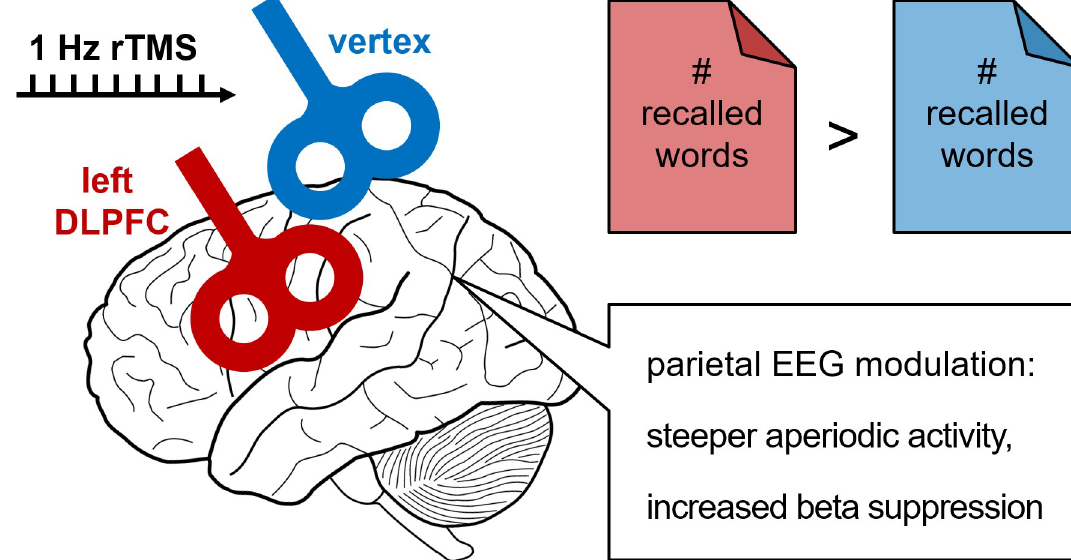
Fig 1. The effect of slow brain stimulation on different brain areas and memory performance. Applying slow (1 pulse per second) rTMS over the left DLPFC (compared to the vertex at top of the head as control region) is associated with enhanced word memory performance (10% to 20% increase). Apart from the effect of rTMS on memory performance, prefrontal stimulation causes enhanced event-related beta suppression at the parietal cortex, a neural response known to be a correlate of memory encoding. However, a further follow-up investigation reveals that increased beta suppression is driven by a steeper slope of aperiodic (scale free) rather than periodic (oscillatory) activity, a feature that reflects a decreased excitation to inhibition ratio of neural electrical currents. D AU : AnabbreviationlisthasbeencompiledforthoseusedthroughoutFig 1 : Pleaseverifythatallentriesarecorrect : LPFC, dorsolateral prefrontal cortex; EEG, electroencephalogram; rTMS, repetitive transcranial magnetic stimulation.